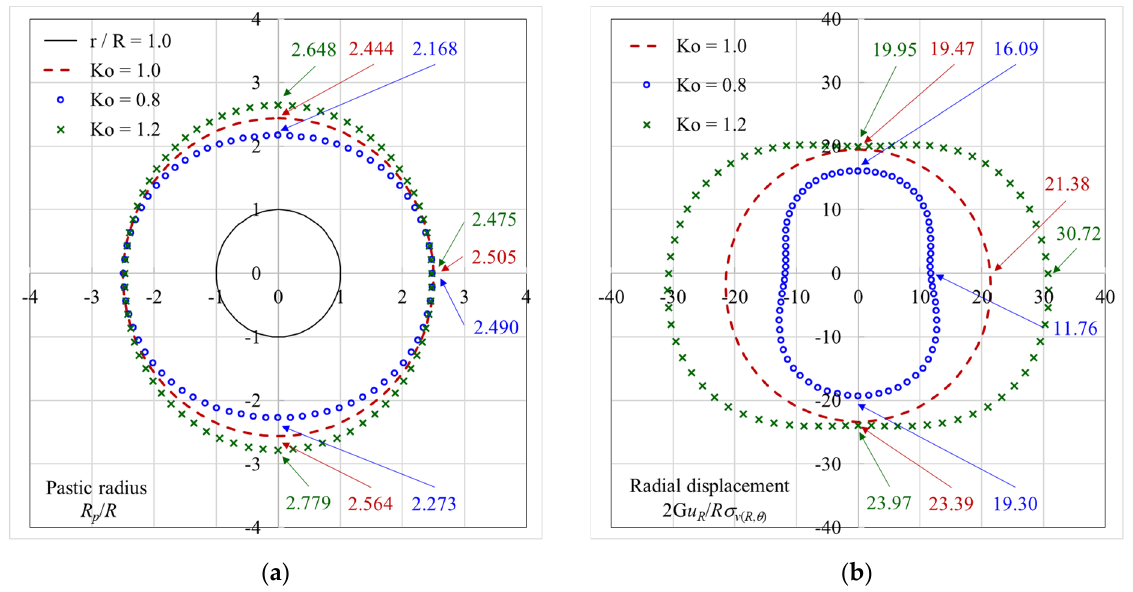
Figure 23. Ground reaction around the tunnel in the elastoplastic media simulated by the EAM with λ = 1.0, and the distribution of ( a ) plastic radius and ( b ) radial displacement.